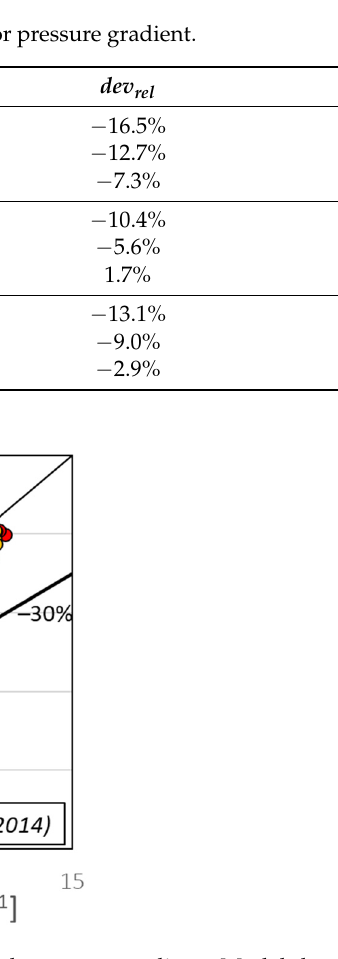
Figure 10. Calculated vs. experimental frictional pressure gradient. Model developed by Diani et al. [39]. Table 5. Accuracy of implemented correlations for pressure